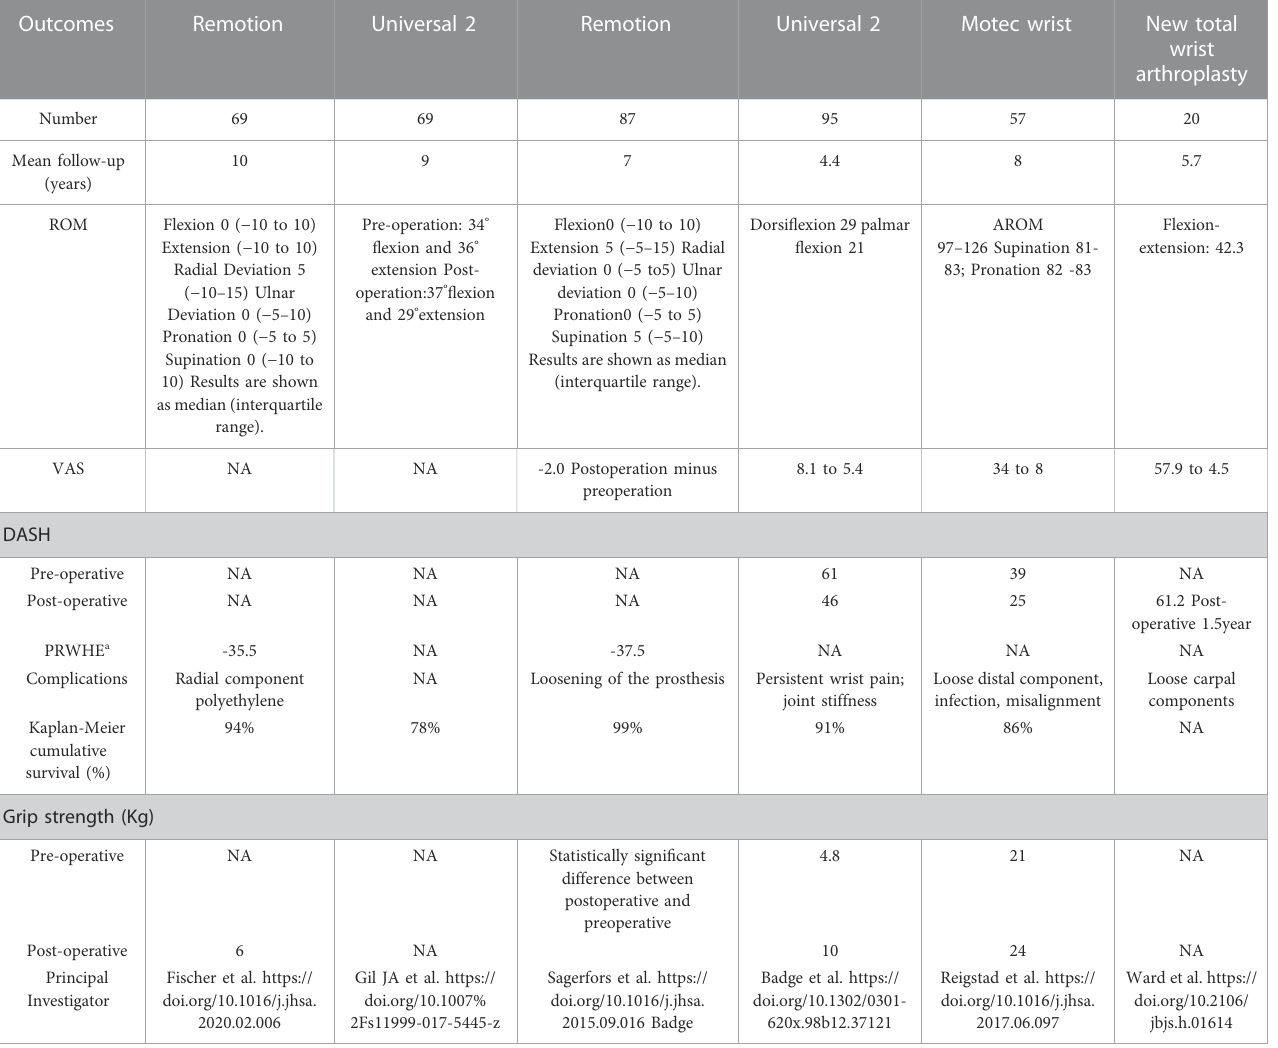
TABLE 4 Reported results and survival with the cementless fourth-generation TWA